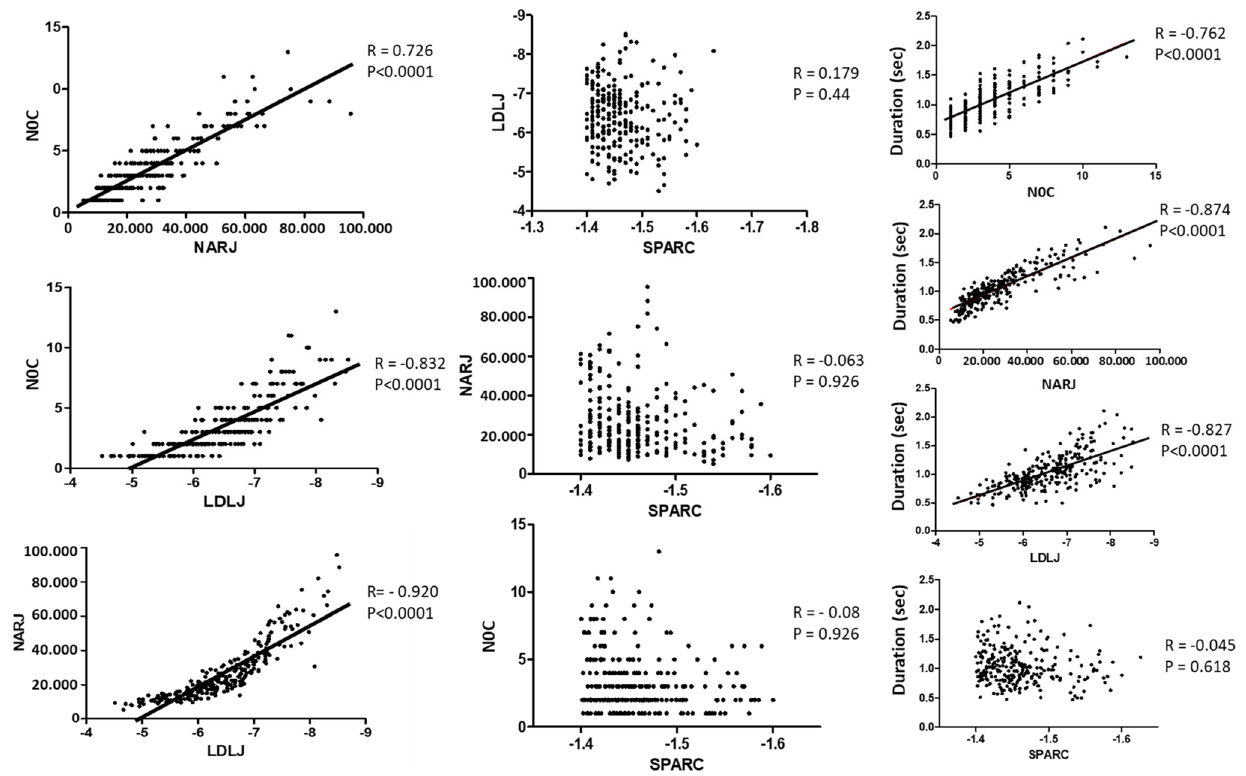
Figure 4. First column: Spearman correlations between temporal domain smoothness metrics. Second column: Spearman correlations between SPARC and temporal domain metrics. Third column: Spearman correlations between smoothness metrics and movement duration.